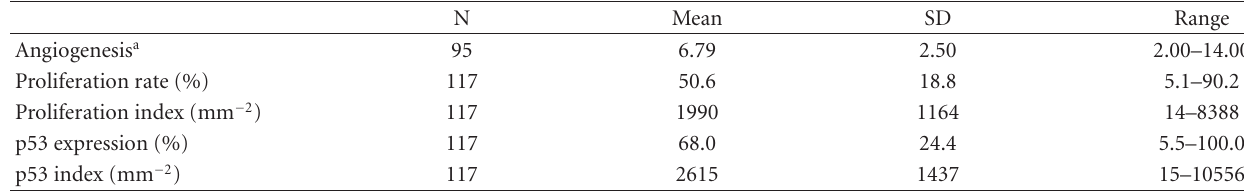
Table 3: Angiogenesis, tumor cell proliferation, and nuclear p53 expression in primary, diagnostic biopsies from osteosarcomas.